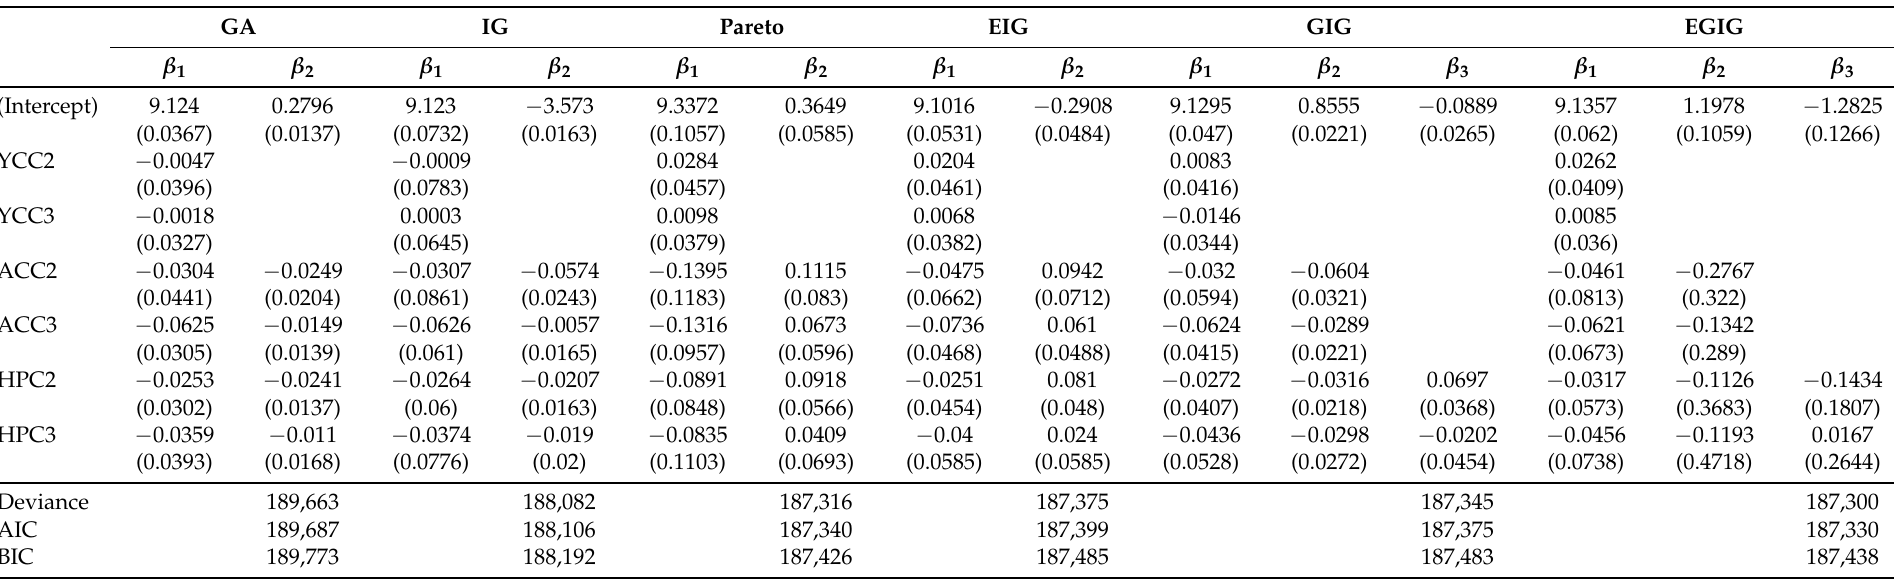
Table 2. Estimation of regression coefficients. GA: Gamma; IG: Inverse Gaussian; EIG: Exponential–Inverse Gaussian; GIG: Generalized Inverse Gaussian; EGIG: Exponential–Generalized Inverse Gaussian; AIC: Akaike information criterion: BIC: Bayesian information